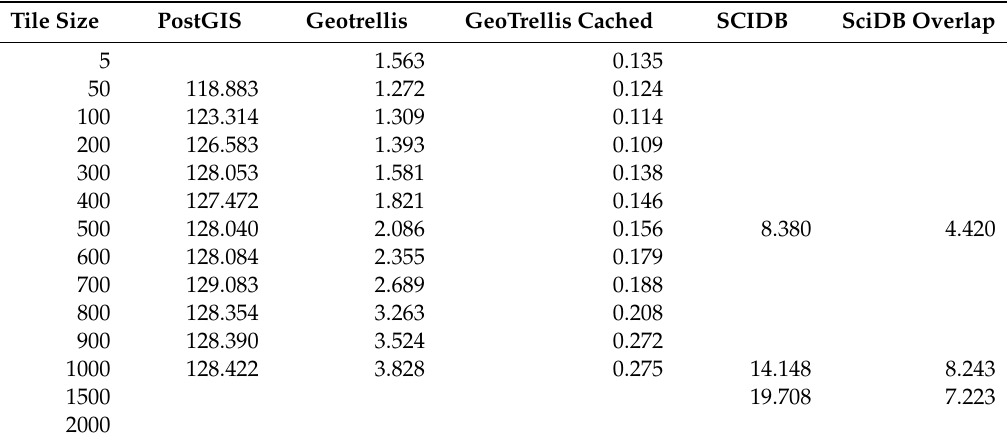
Table 8. Focal analysis performance times in seconds on